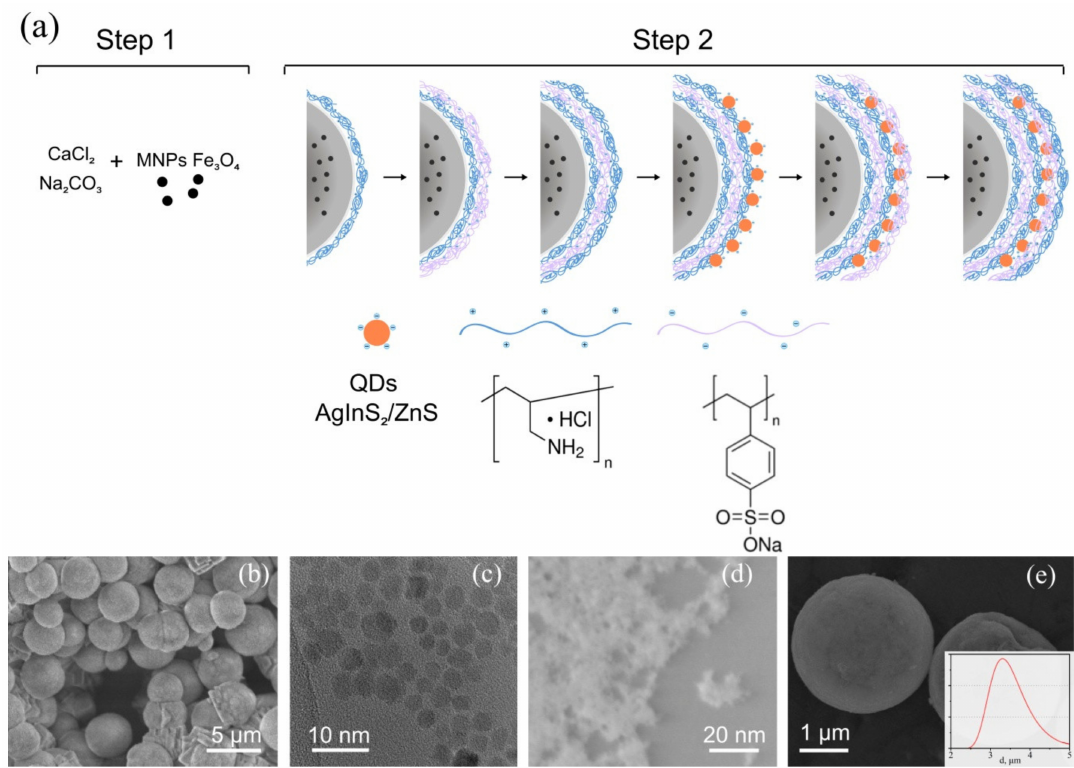
Figure 1. ( a ) Scheme of a two-stage synthesis of a magnetic luminescent sensor based on CaCO 3 microspheres, ( b − e ) SEM and STEM images of the sensor components: ( b ) CaCO 3 microspheres, doped by Fe 3 O 4 nanoparticles, ( c ) Fe 3 O 4 magnetic nanoparticles, ( d ) AgInS 2 / ZnS quantum dots (QDs) stabilized with thioglycolic acid (TGA), ( e ) CFA (CaCO 3 -Fe 3 O 4 -AgInS 2 / ZnS) microspheres with polyelectrolyte shell poly(allylamine hydrochloride) / poly(sodium 4-styrenesulfonate) (PAH / PSS). Inset in ( e ) shows a typical dynamic light scattering (DLS) size-distribution